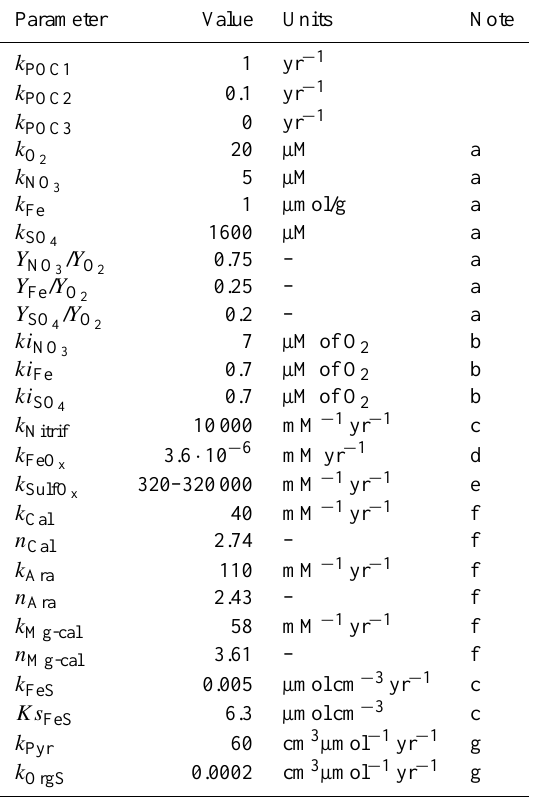
Table 5. Selected parameters for kinetic equations. Parameter Value Units Note phate sorption onto ferric iron phases is also modeled. The